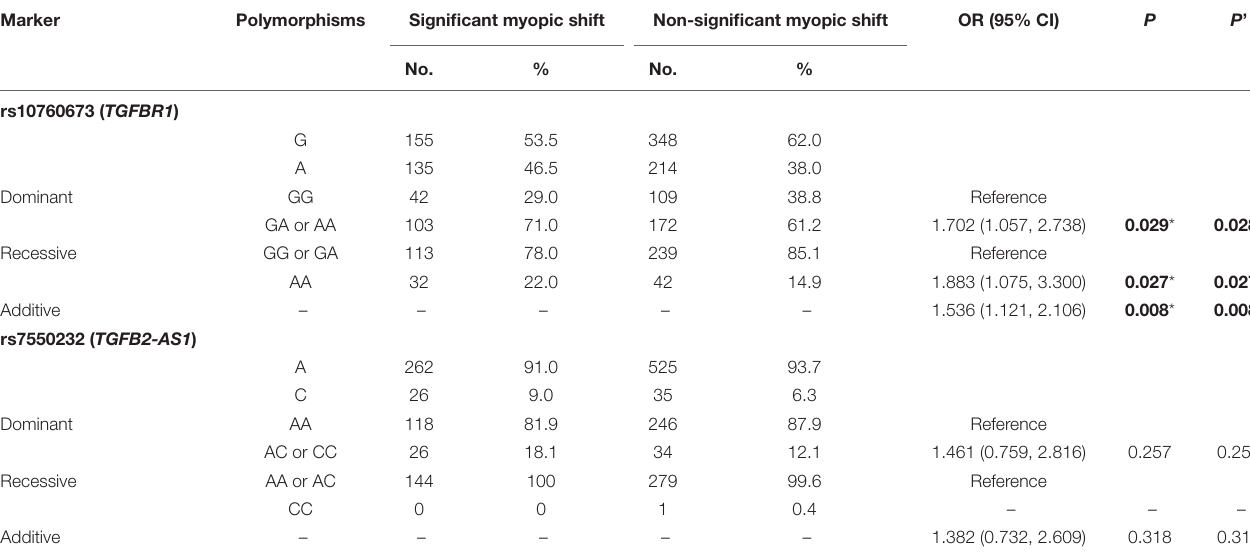
TABLE 4 | Associations between genetic polymorphisms and myopia progression in various genetic